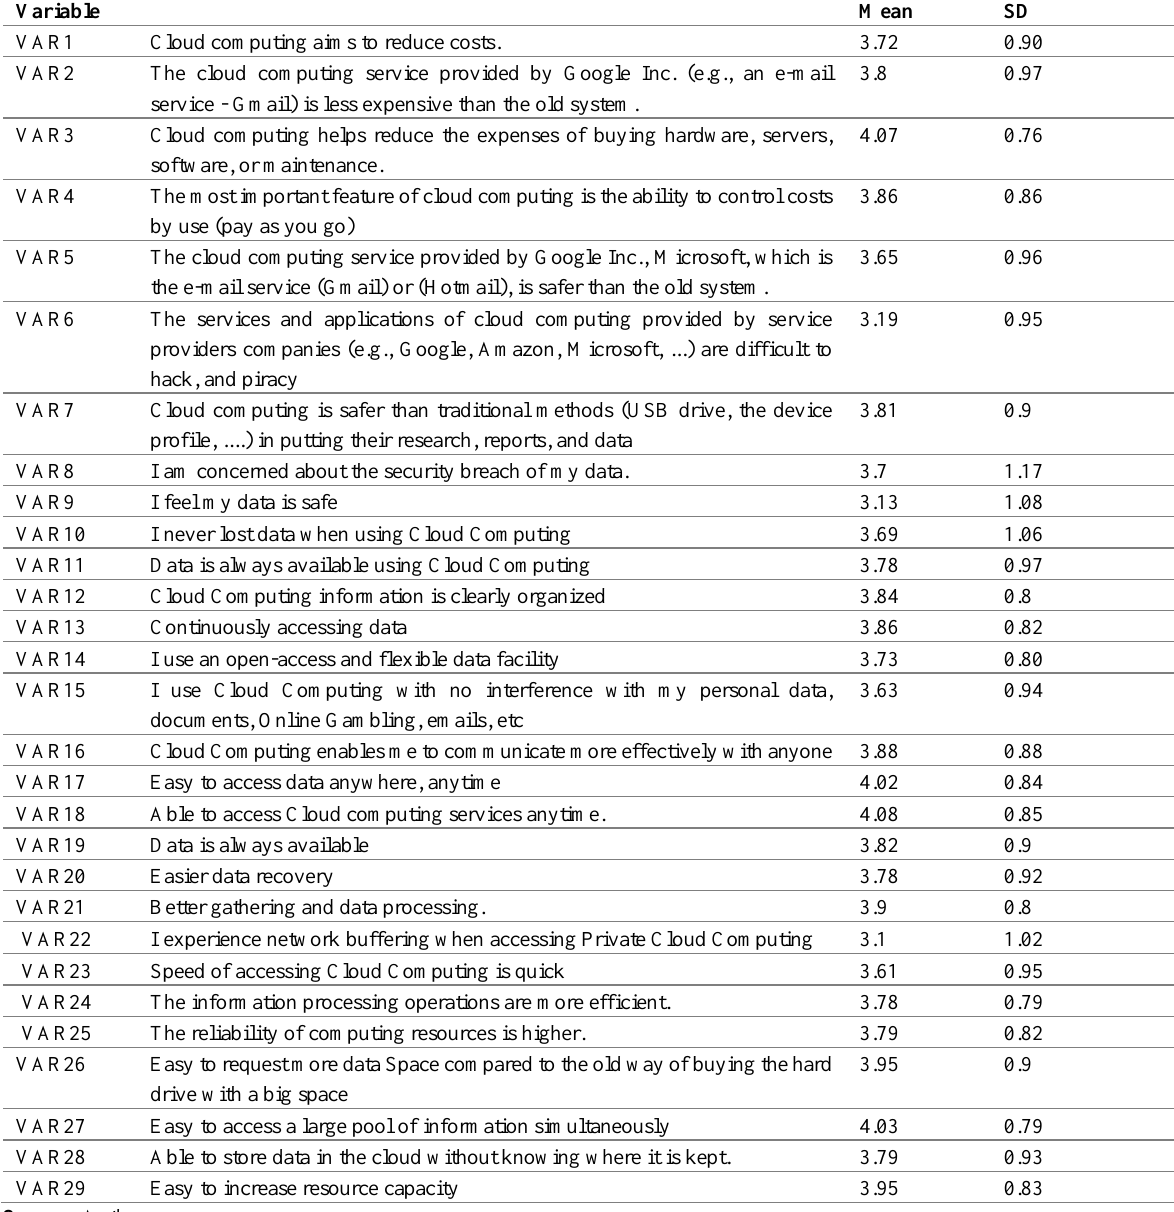
Table 2: Descriptive Statistics with Relative Importance